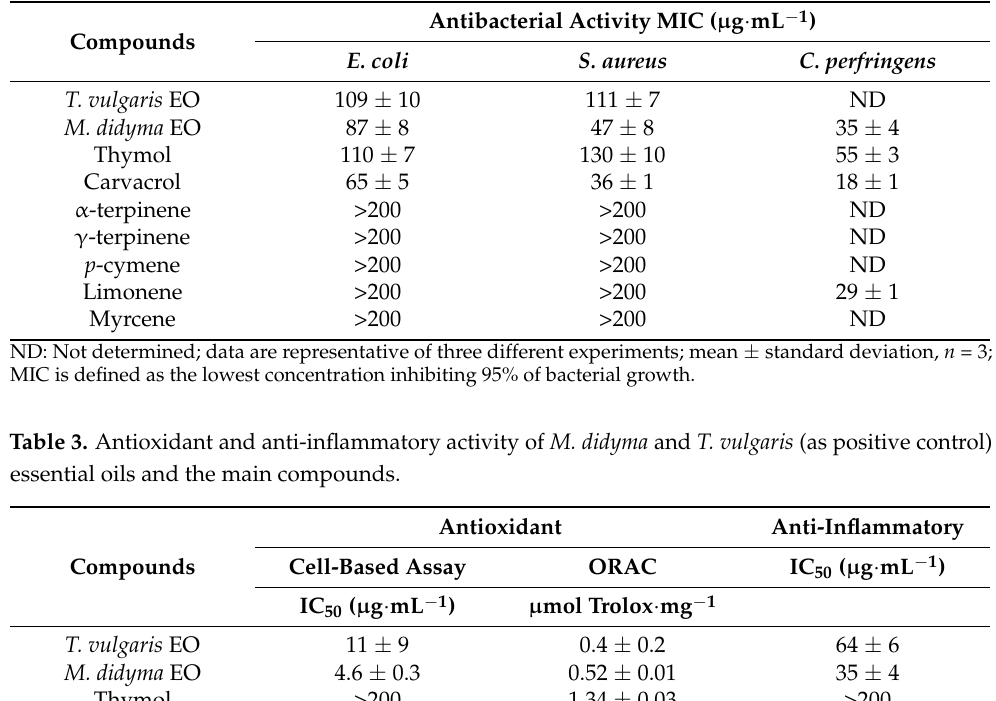
Table 2. Antibacterial activity of M. didyma and T. vulgaris (as positive control) essential oils and the main compounds against selected bacterial strains.